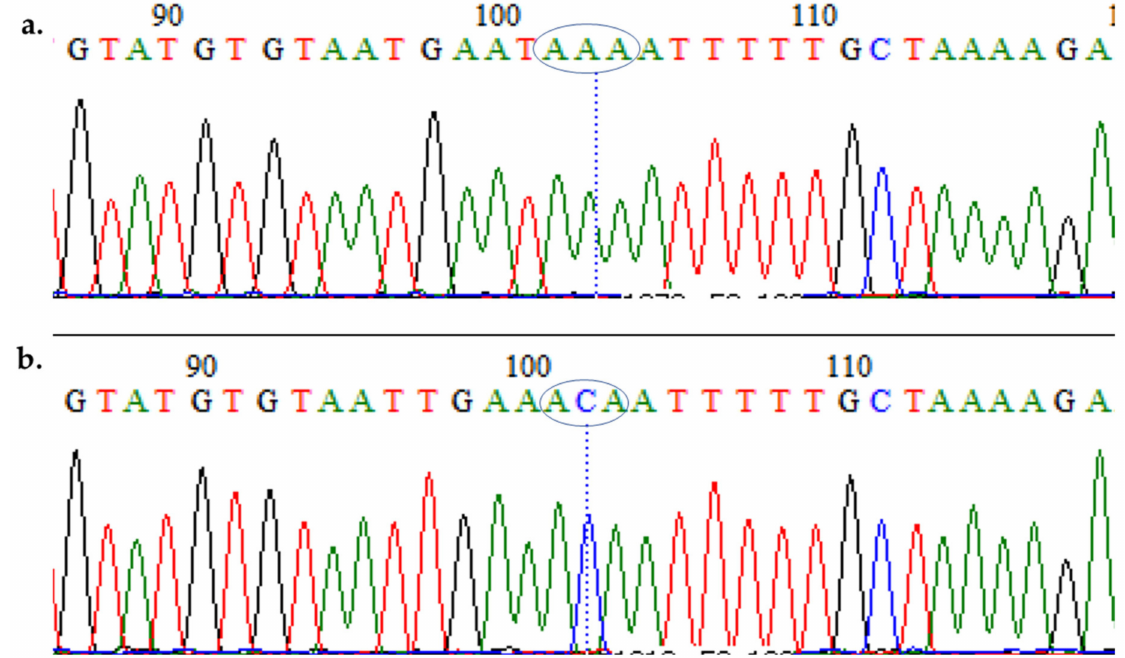
Figure 4. Analysis of the polymorphism of a fragment of the pfcrt spanning the 76th codon. Polymorphic codons for ( a ) CQS isolate bearing a CVMNK haplotype; and ( b ) CQR isolates bearing the CVIET